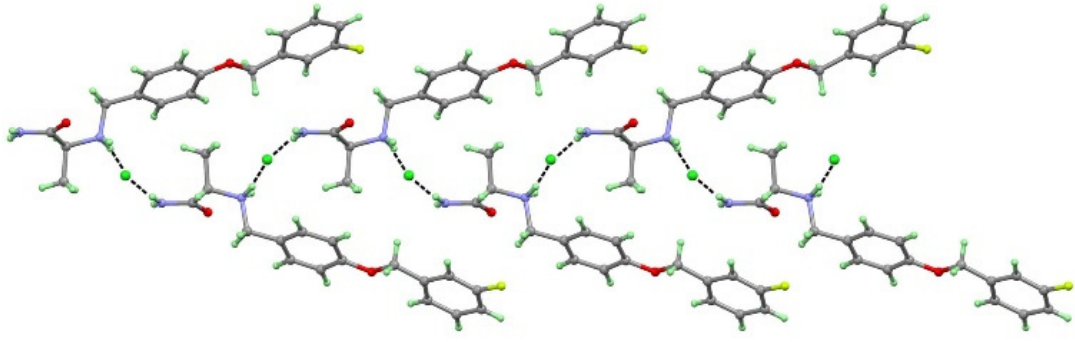
Figure 2. Safinamide (SAF) cations and hydrochloric acid (HCl) anions form a one-dimension zigzag chain